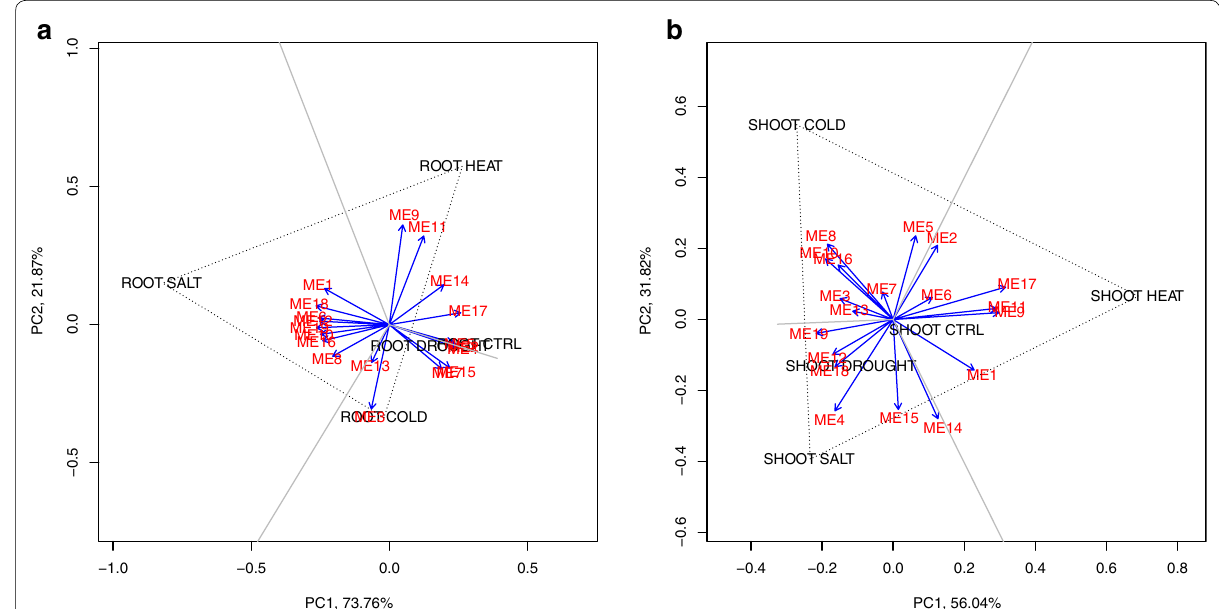
Fig. 3 Biplots of 19 Eigen genes and 5 stress conditions. Those biplots were consisting of 19 Eigen genes (ME1 to ME19) and 5 stress conditions (cold, heat, salt, drought, and control) for a root tissues, and b shoot tissues, respectively